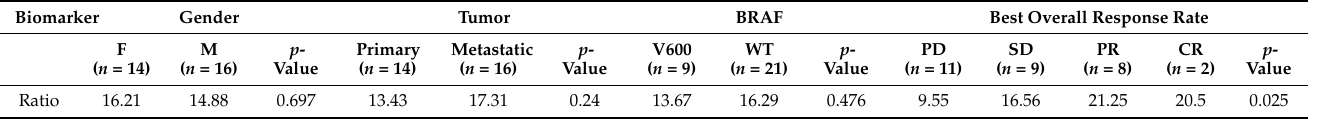
Figure 3. Kruskal–Wallis test. Relationship between the applied ratio and BORR. Table 5. Relationship between ratio and pathological features. Representation of the intersection among the ratio and some patients’ clinical characteristics, using the mean ranks of the analyzed groups, obtained with the Mann–Whitney test and Kruskal–Wallis rank